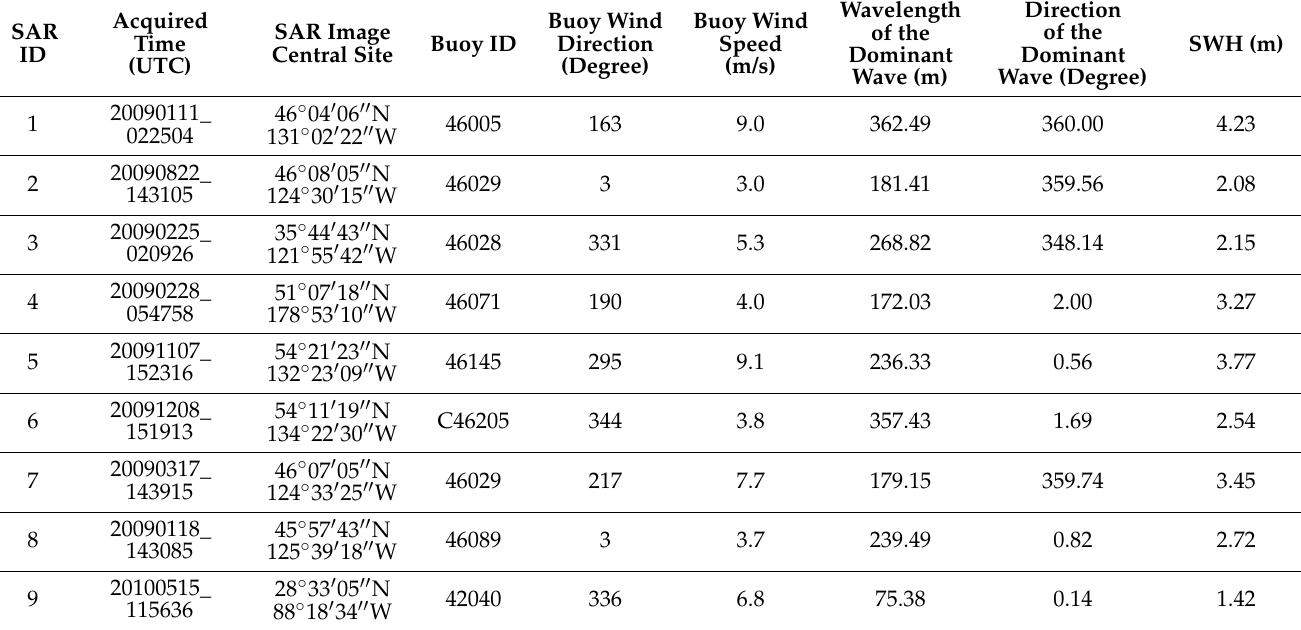
Table 1. The information of the actual RADARSAT-2 SAR images and marine